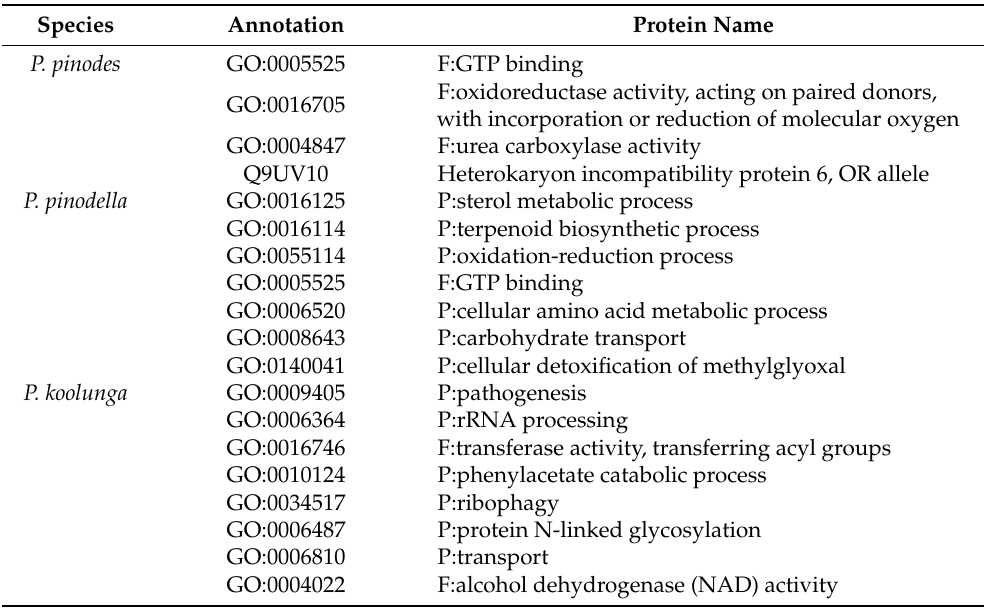
Figure 5. Venn diagrams of AB inter and intra-species orthology showing shared gene families (gene clusters). Venn diagrams and summary tables showing orthologs for the reference isolates P. pinodes , P. pinodella , and P. koolunga. ( a ) Orthologous gene clusters among P. pinodes species. ( b ) Orthologous gene clusters among P. pinodella species. ( c ) Orthologous gene clusters among P. koolunga species. ( d ) Orthologous gene clusters between the three AB species using the reference isolates Isolate2Pk, Isolate3Pp, and Isolate18Ppll. Table 5. Annotation for unique